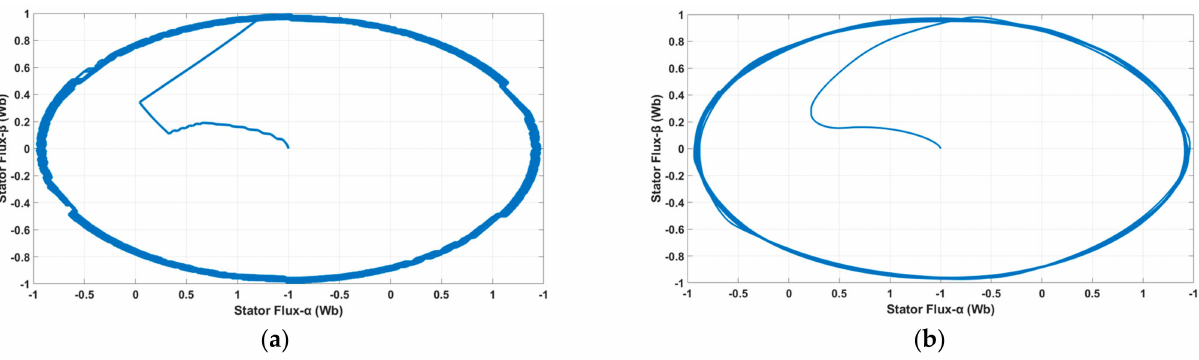
Figure 17. Stator flux trajectory with ( a ) 6 − sectors and ( b ) 12 − sectors DTC control strategies.